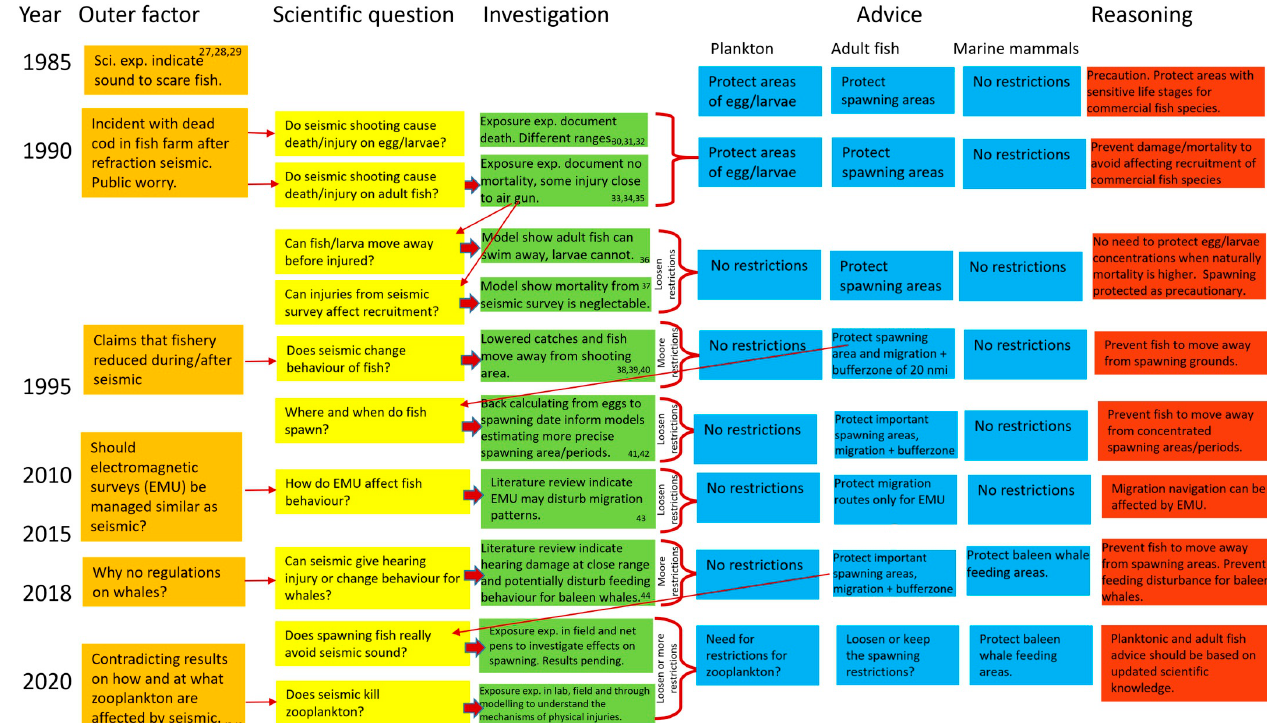
Figure 1. Overview of how management advice has changed since the beginning of the advisory practice in the late 1980s. The “Outer factor” column covers drivers from outside the scientific community that may induce new scientific questions and lead to research activity. The “Scientific question” column lists the research questions being raised to improve management advice, which may arise from outer factors or from existing research that raises new questions. The “Scientific investigation” column briefly describes the main findings from research projects. The “Advice” column summarizes the management advice from IMR to the Norwegian Petroleum Directorate and is divided into different advice given for three specific groups of animals; plankton (small organisms with very little or no self-movement, including egg, fry, larvae, and zooplankton), adult fish, and marine mammals. The “Reasoning” column describes the rationale for the particular advice given. Timeline is indicative and not to scale. The numbers in the bottom corner refer to publications given in the reference list;